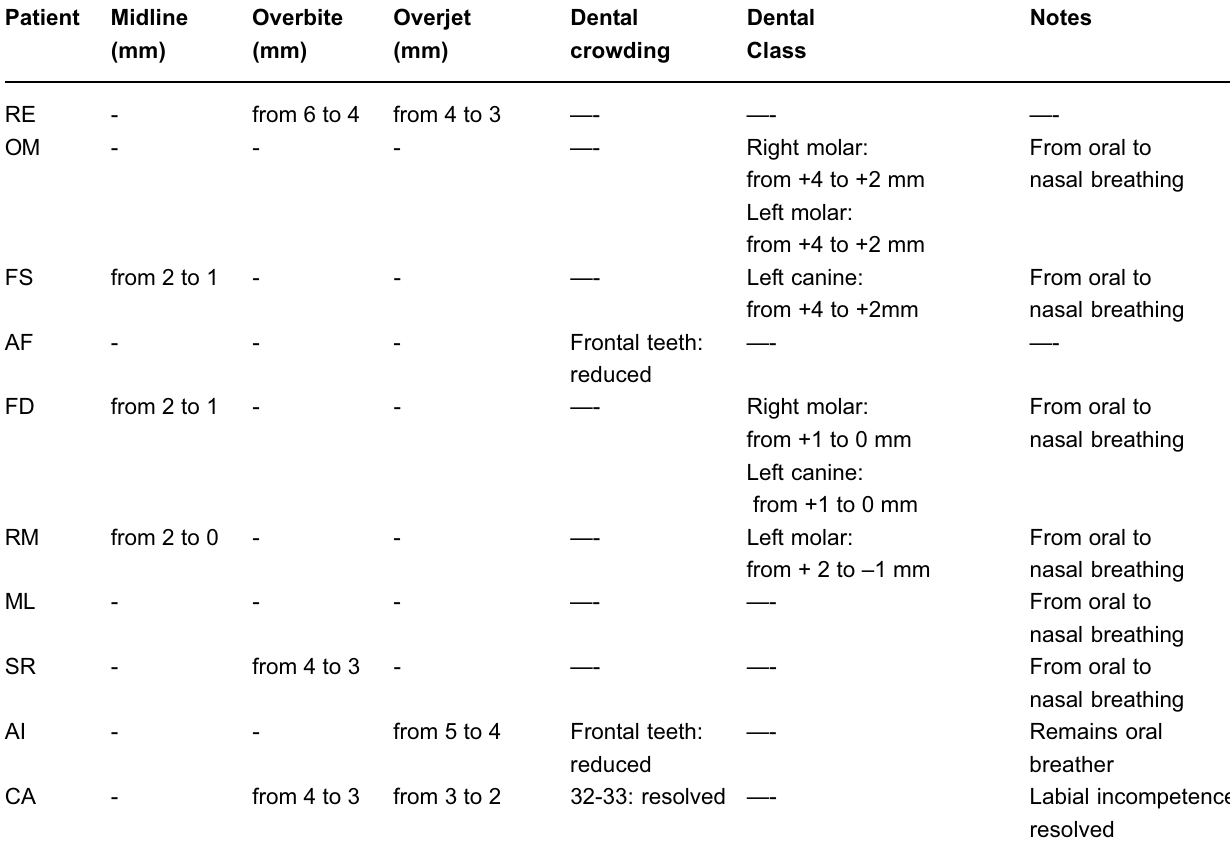
TABLE 3- Modifications of the clinical characteristics of the analyzed orthodontic patients during the 6-month